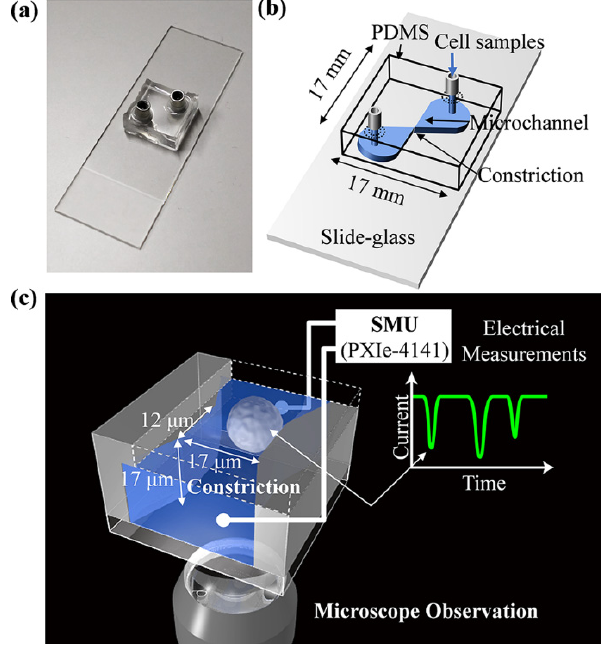
Figure 1. Microfluidic cell sensing chip. ( a ) Picture of microfluidic cell sensing chip made of polydimethyl siloxane (PDMS) fabricated on a slide glass. ( b ) Design of the mold used for the SU-8 microchannel. One constriction operating as a narrow flow path was formed. The microchannel was formed at the bottom of a replicated PDMS and sealed using a slide glass. The cell samples in 1.0 × phosphate-buffered saline (PBS) or 0.5 × PBS were injected from the inlet through a hole connecting the microchannel until it was full. For each analysis, 7 µ L of electrolyte solution was added to the inlet reservoir to apply a pressure of 10 Pa. ( c ) Schematic illustration of ionic current blockade by resistive pulse method (RPM). Each constriction was 17 µ m in width, 12 µ m in length, and 17 µ m in height. The translocation of cells through a constriction generated a pulse-like ionic current blockade, and electrical signals were then measured as a source measurement unit